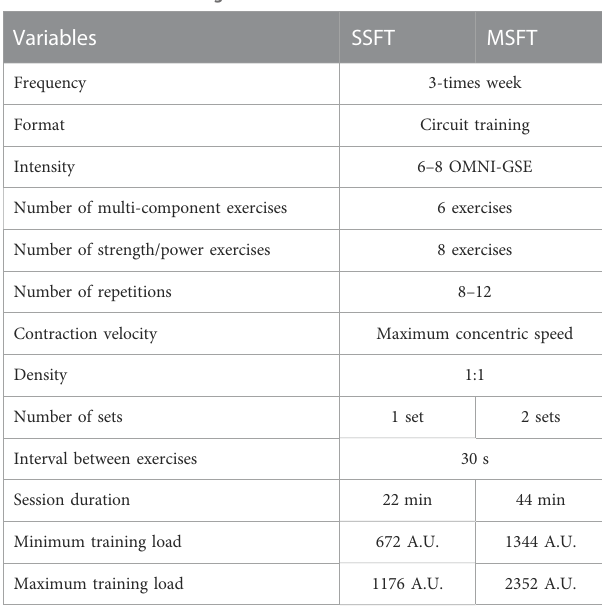
TABLE 1 Functional training